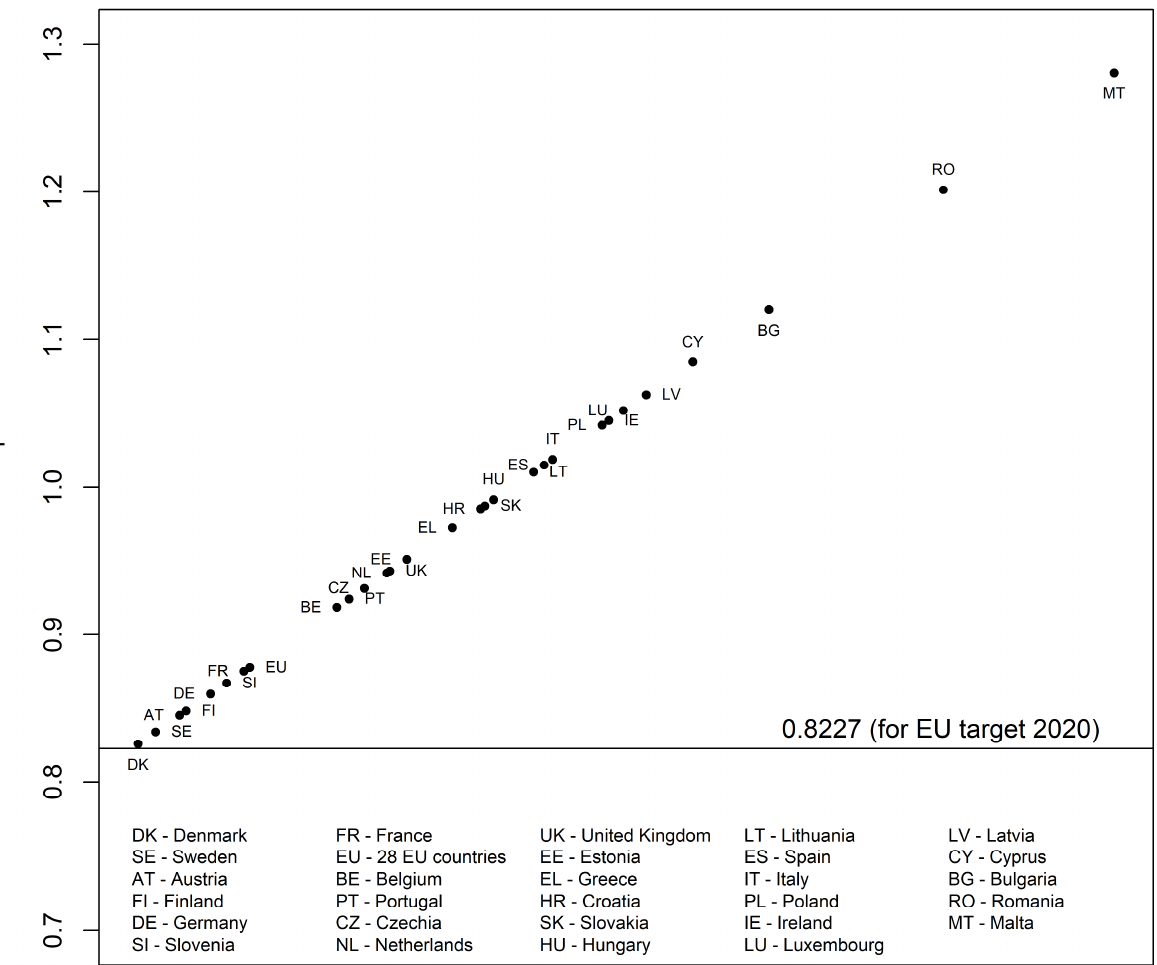
Figure 1. Ranking of the 28 European Union countries for 2019 based on the value of SM it aggregate measure for the EU-level target analysis. Source: authors’ compilation.